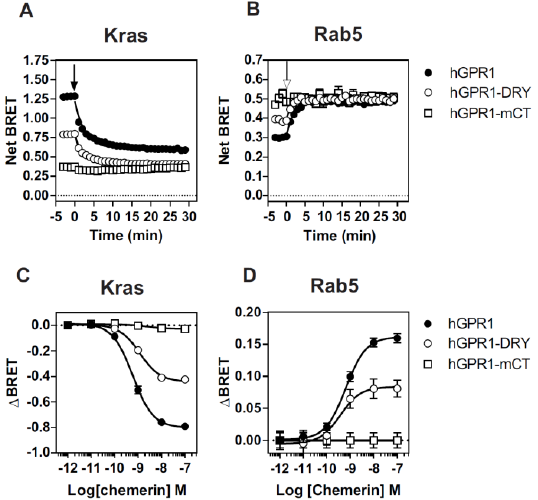
Figure 9. R 3.50 and the C-terminus of mGPR1 are involved in its subcellular localization and traf- ficking. ( A , B ) Real-time measurement of BRET signal in HEK293T cells expressing hGPR1-RLuc ( ● ), hGPR1-DRY- R Luc ( ○ ) or hGPR1-mCT- R Luc ( □ ) in combination with the plasma membrane acceptor KRas-Venus ( A ) or the early endosome acceptor Rab5-Venus ( B ), in basal conditions and after stimulation with 100 nM chemerin. Results are expressed as Net BRET corresponding to the BRET signal measured between the donor and the acceptor minus the BRET signal measured with the donor only. ( C , D ) Real-time measurement of the BRET signal measured 30 min after simulation with increasing concentrations of chemerin. Results are expressed as ∆ BRET corresponding to the difference between the BRET signal measured before and after stimulation with chemerin. Data represent the mean ± SEM of three independent